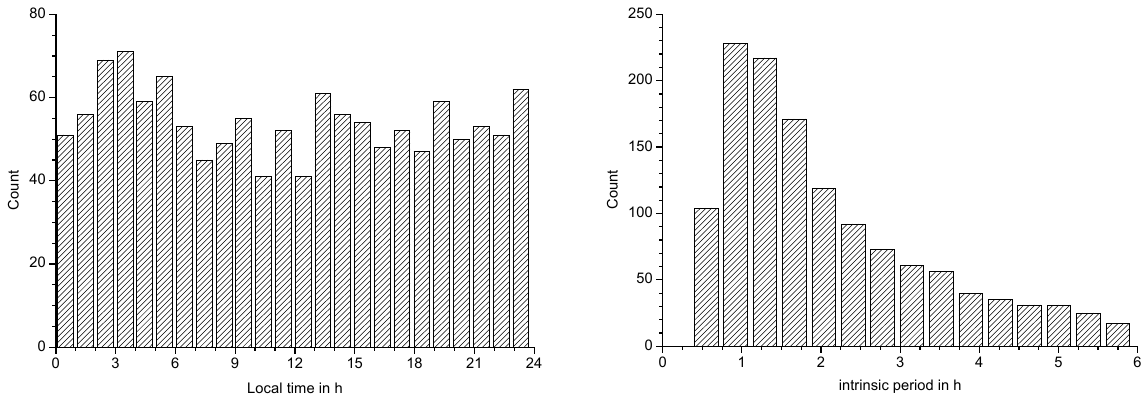
Fig. 5. Histograms of IGW occurrence during the day (left panel) and period distribution (right panel) of IGWs. The upper and lower limits in the left panel are due to the resolution limitations of measurements and data analysis procedure.